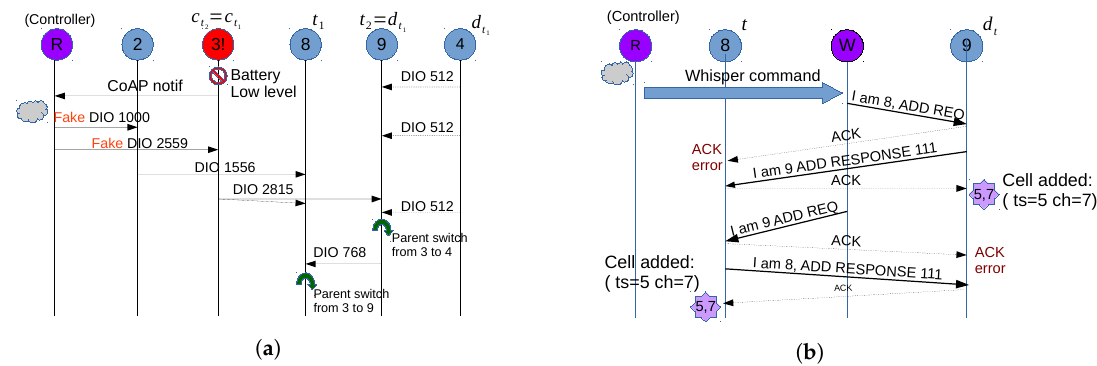
Figure 5. Example of sequence of messages for a parent switch and a 6P cell allocation. ( a ) parent switch for use case 1 in Figure 2a); ( b ) cell allocation for Example 1 in Figure